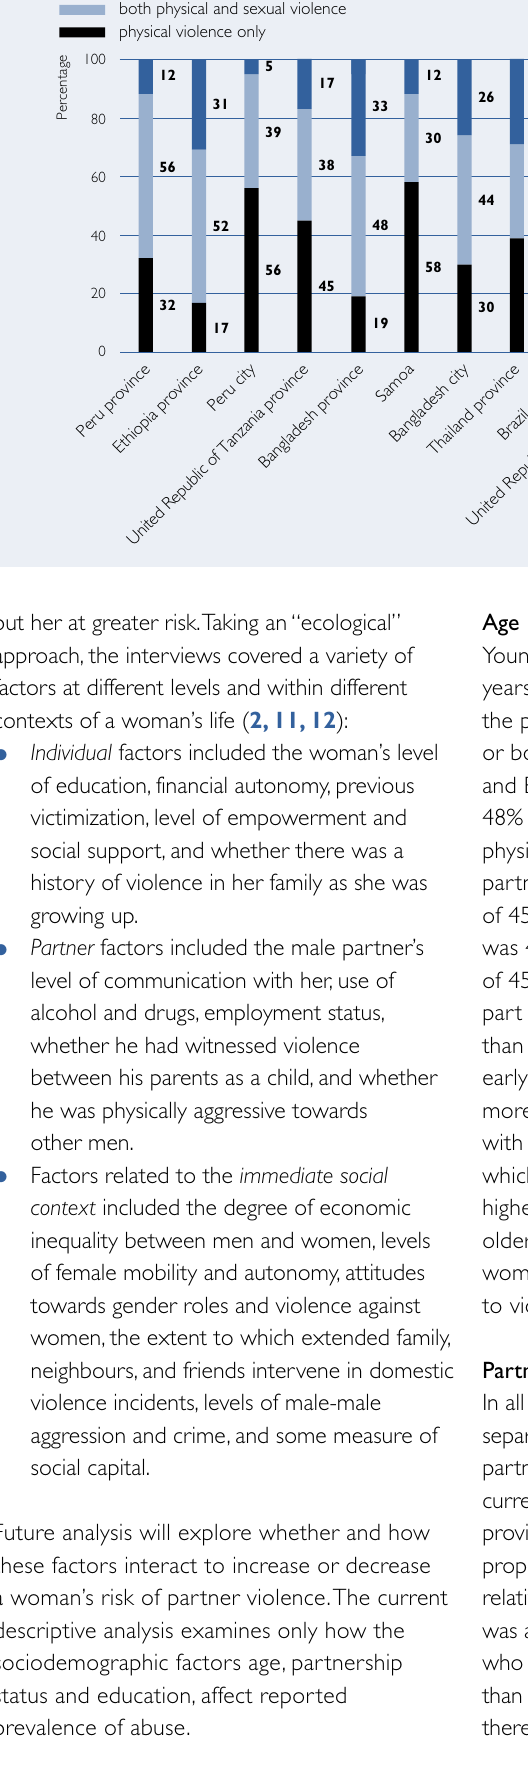
Figure 4 Frequency distribution of types of violence by an intimate partner among ever-abused women, by site sexual violence only both physical and sexual violence physical violence